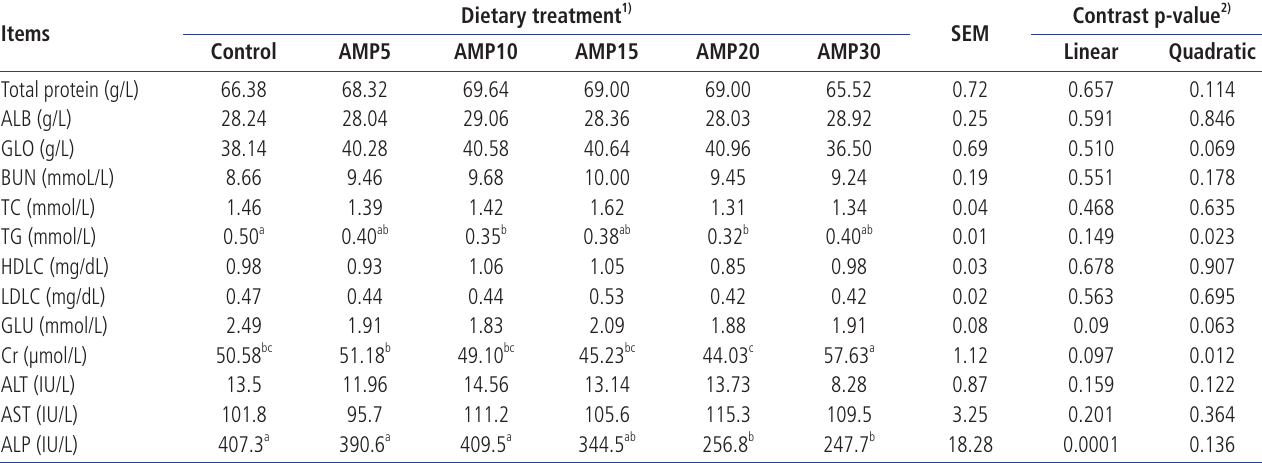
Table 3. Effects of the Astragalus membranaceus roots supplementation on serum biochemical index and enzymes related to liver function of ram lambs Items